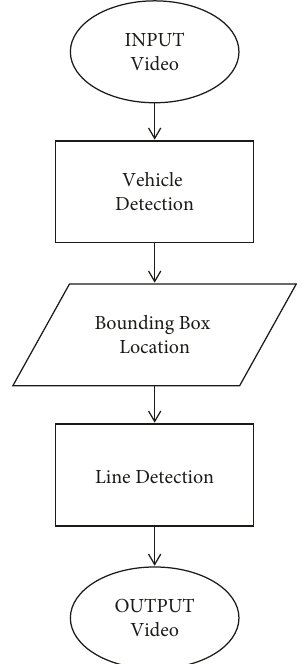
Figure 1: An overview of the proposed system